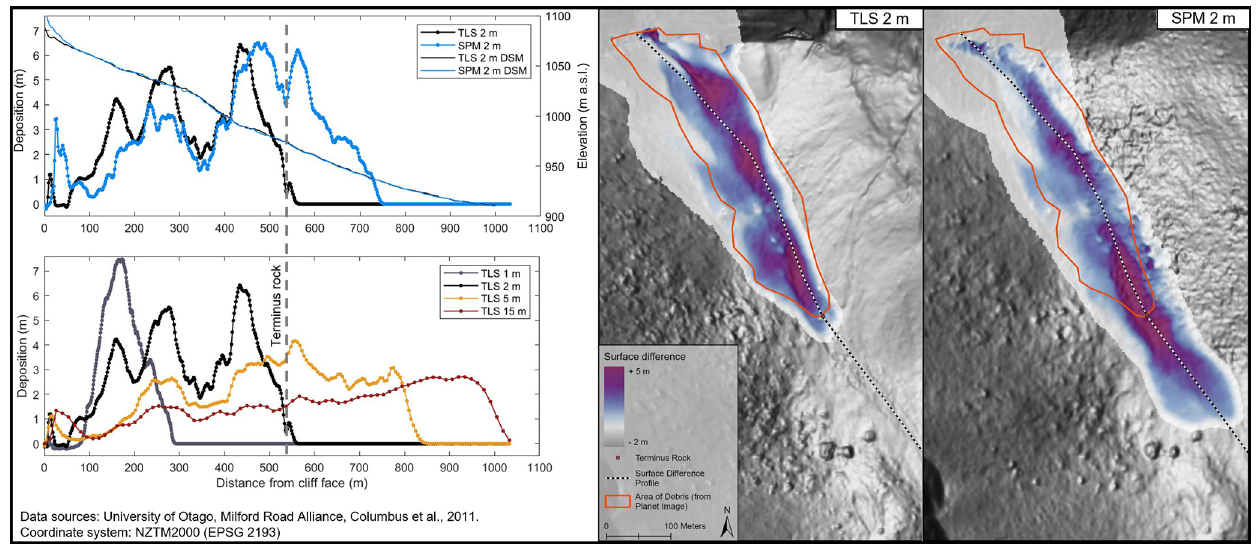
Figure 8. Profile of simulated debris from lower cliff face through runout zone between TLS and SPM 2m simulations (top left panel), including the 2m TLS and SPM elevation profile for reference, and between TLS 1, 2, 5 and 15m simulations (lower left panel). Examples of simulated debris patterns for TLS and SPM 2m simulations (right side panel) show how well debris pattern matches documentation (orange